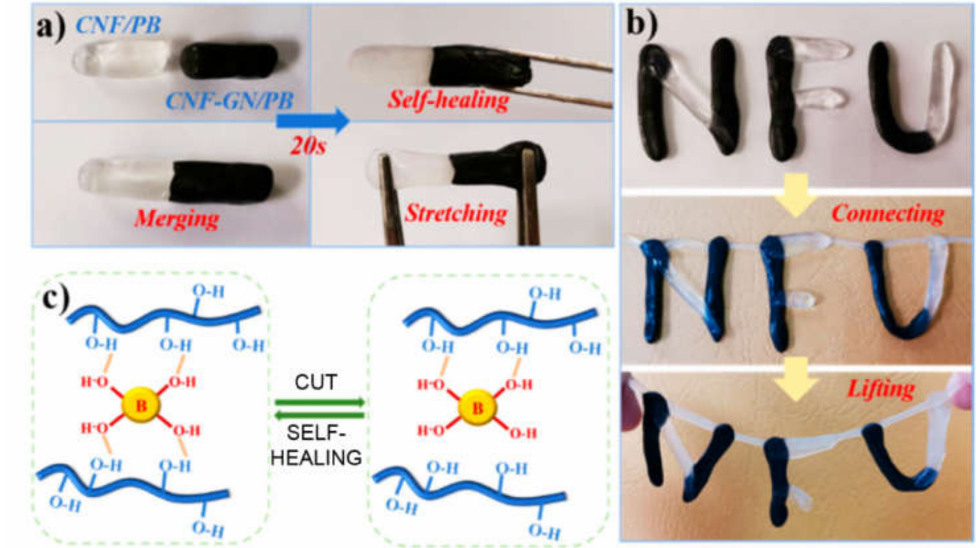
Figure 5. Self-healing GO-PVA hydrogel. ( a , b ) examples of the self-healing ability. ( c ) self- healing mechanism based on the use of borax as cross-linker between hydroxyl groups of PVA polymer. Reproduced from Zheng, C. et al. (2019) [87], under a Creative Commons license